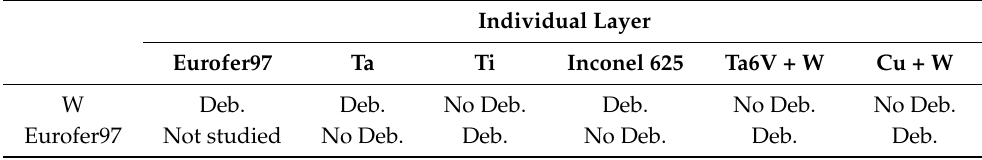
Table 4. Quality of the studied interface, assessed by the presence of cracks at